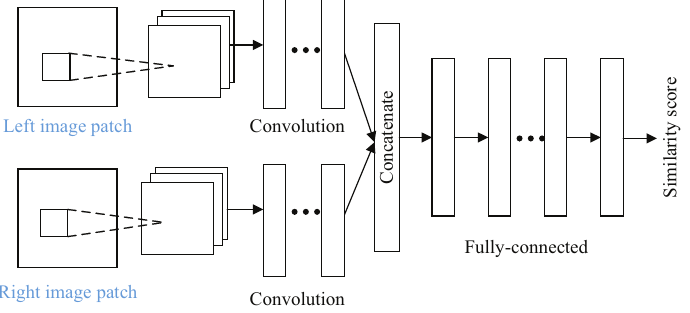
Figure 11. The structure of MC-CNN proposed in